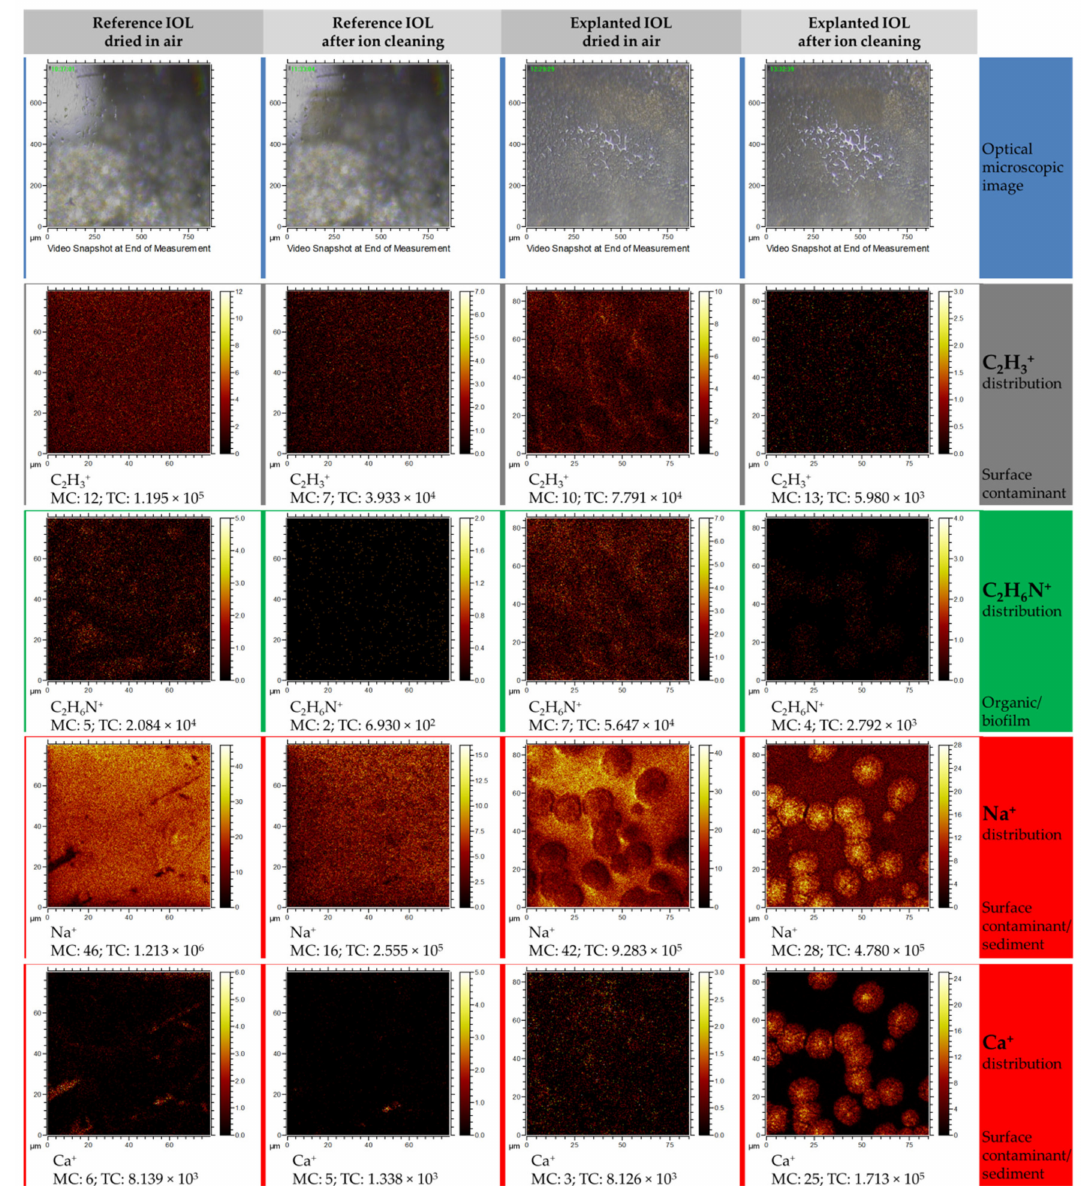
Figure 7. Time of flight secondary ion mass spectrometry (TOF–SIMS) distribution maps of selected elemental and molecular ions obtained in positive polarity mode measurements. Each column represents a set of distribution maps of C 2 H 3 + , C 2 H 6 N + , Na + , and Ca + . The first and second columns represent the ions’ distribution for the reference lens before and after cleaning procedure, respectively. The third and fourth columns show before and after cleaning of the explanted lens,